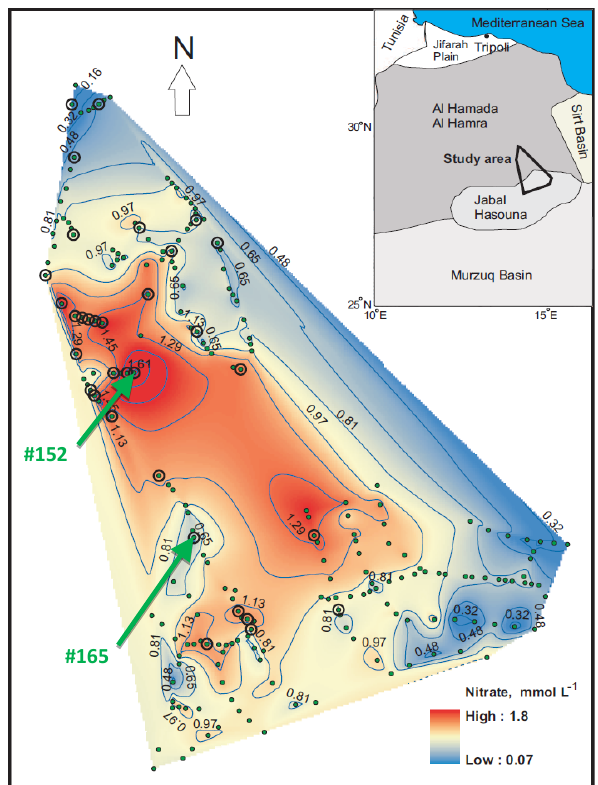
Fig. 1. Sampling sites ( 〇; n= 28) and distribution of nitrate in paleo groundwater from Hasouna, Libya. Isolines are obtained from a total of 57 NO 3- analyses of paleo Figure 1. Sampling sites ( (cid:13) ; n = 28) and distribution of NO − in 3 paleo-groundwater from Hasouna, Libya. Isolines are obtained from groundwater from wells ( ● ). 5 ). a total of 57NO − analyses of paleo-groundwater from wells ( 3 Fig. 2. Calcium concentration reduced by the proportion gained from calcium carbonate dissolution by considering dolostone dissolution ([Ca 2+ ] + [Mg 2+ ] - 0.5 [HCO 3- ], mM) vs. the concentration of dissolved sulfate, [SO 42- ] (mM). The linear relationship with a slope of 1 fits the composition of the Hasouna groundwaters quite 10 well and reflects the dissolution of calcium sulfate minerals, like gypsum. Fig. 3. Chemical composition of groundwaters from Hasouna, Libya. a: Na + versus Cl - concentration. b: Ca 2+ versus NO 3- concentration. Values are given in mM. Solid green lines: Mixing between end-member solutions #165 and #152 with lowest and 15 highest ion concentrations, respectively. Dotted arrows: Chemical trend for evaporation of solution #165, where 50 and 75% denote ion concentrations at respective loss of H O by evaporation. Solid arrow: Decrease of Ca 2+ concentration 2 by considering calcite precipitation to reach SI = 0. Dashed red line: MCL for calcite water recharge periods are still disputed; Pleistocene NO 3- in drinking water according to WHO (WHO, 2004). 20 Fig. 4. Stable hydrogen and oxygen isotope composition of groundwater from North Africa. Paleo groundwater displays lower stable isotope values and an elevated d-excess compared to modern precipitation, which indicates recharge under cooler and more humid climate conditions versus modern climate conditions. The analytic 25 inaccuracies lay within the size of the symbols. Isotope composition of Modern Eastern Mediterranean seawater is out the displayed range, comprising  18 O values from 0.3 to 2.5 ‰ and  D values ≈ 0 ‰ (Gat, 2010). ● : Hasouna, Libya (this study); ■: Hasouna, Libya, isotope range (Milne-Home and Sahli, 2007) ; □: Murzuq Basin, Libya, isotopic range (Sonntag et al., 1978) ; Δ: Arab 30 Jamahiriya, Libya ( Srdoč et al., 1980 ) ;▲: South Tunisia (Abid et al., 2012) ; ♦: Wadi Ash Shati Valley, Libya (Salem et al., 1980). x : Groundwater recharged by modern precipitation close to Tripoli (own data). GMWL: Global Meteoric Water Line (  D = 8  18 O + 10; Craig, 1961). LMWL: Local Meteoric Water Line for Sfax metereological